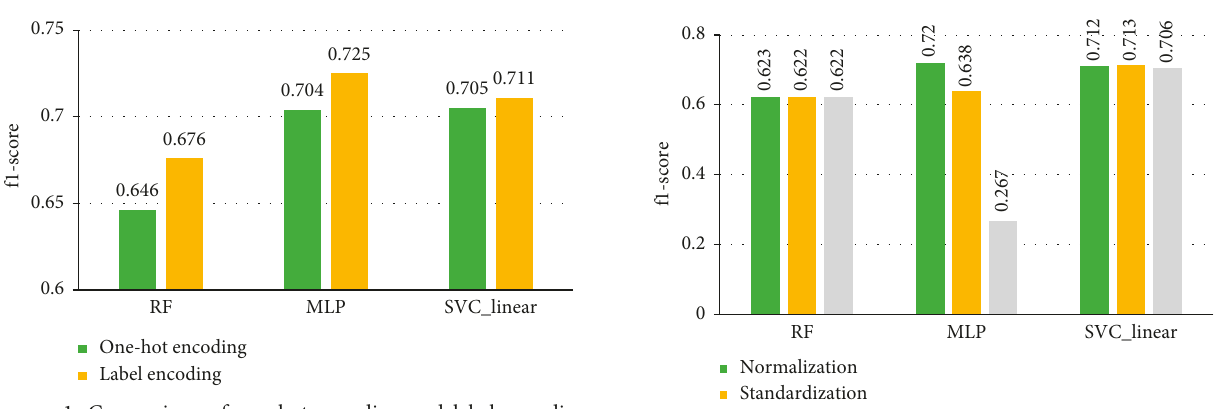
Figure 1: Comparison of one-hot encoding and label encoding over wind direction.